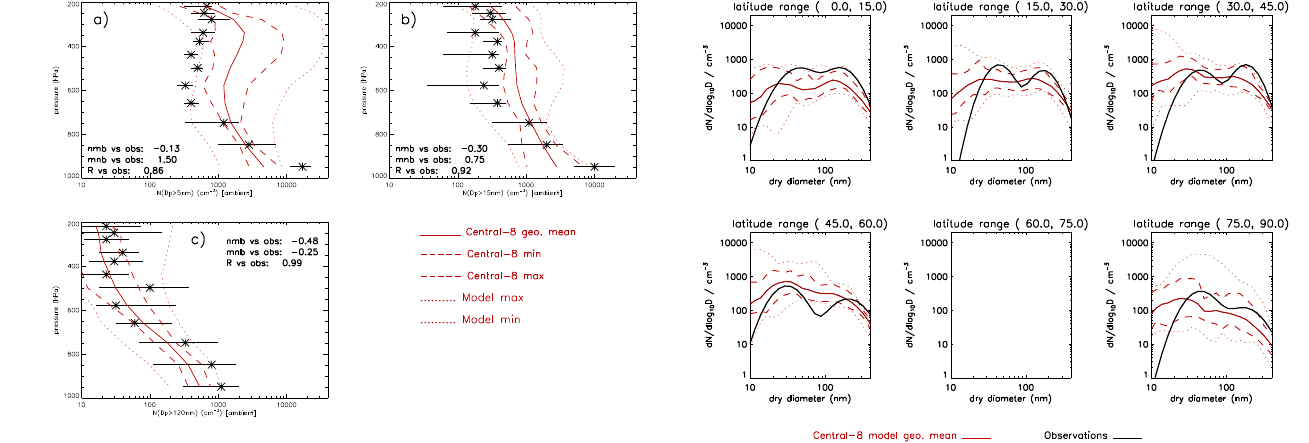
Figure 18. Summertime central-model simulated profiles of N(D p > 5nm) (a) , N(D p > 15nm) (b) , and N(D p > 120nm) (c) , over Germany against those derived from aircraft-borne CPC and PCASP measurements (asterisks) during the Lindenberg Aerosol Characterisation Experiment (Petzold et al., 2002), as presented by Lauer et al. (2005). The solid line shows the geometric mean of the central-8 models, dashed lines indicate the maximum and minimum of the central-8, while dotted lines indicate the maximum and min- imum over all 12 models.